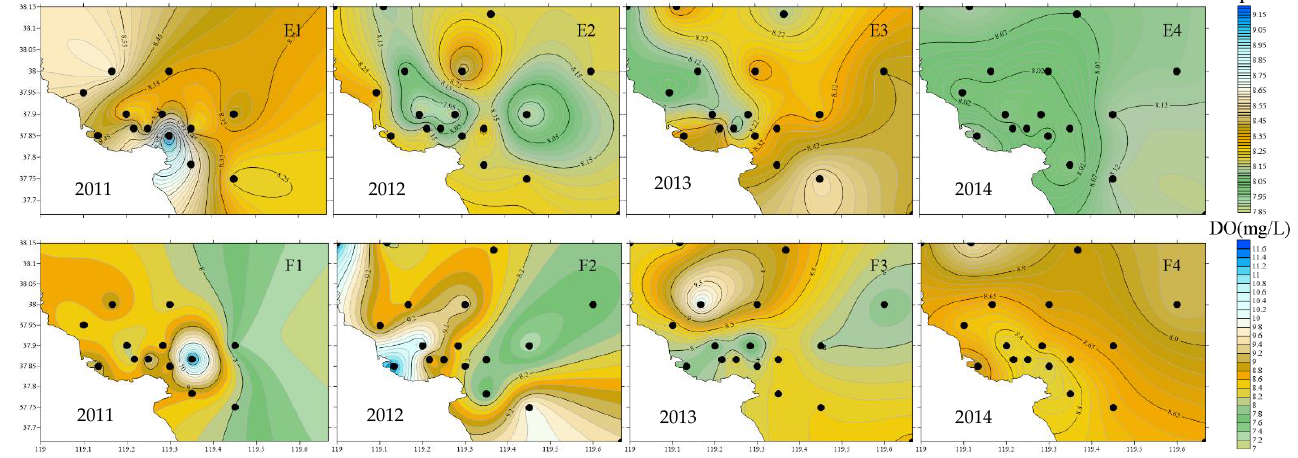
Figure 3. Changes in environmental factors in the Yellow River estuary waters from 2011 to 2014 ( A1 – F4 ). Table 1. Composition of environmental factors in the Yellow River estuary.